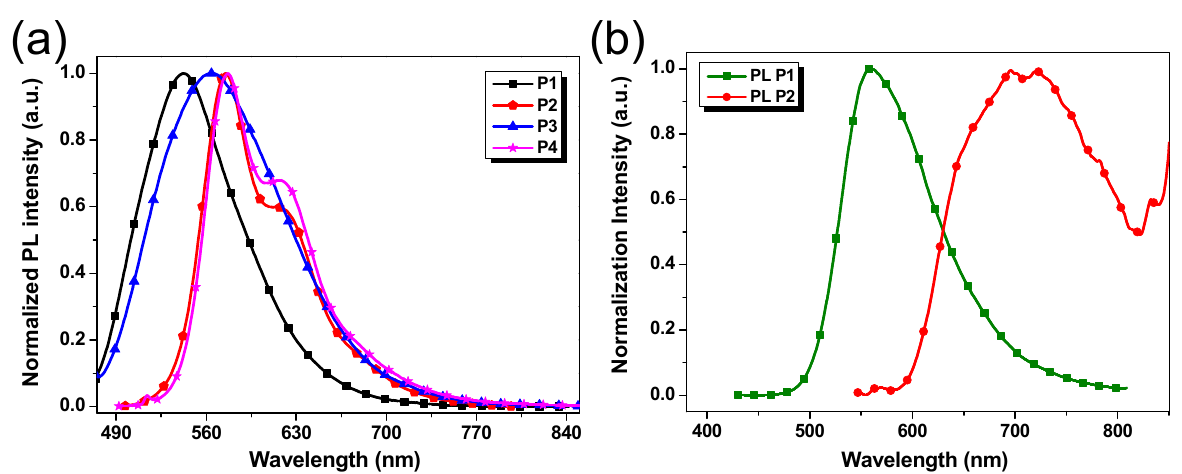
Figure 4. ( a ) Normalized PL spectra of P1 – P4 in dilute chloroform solutions (1 × 10 − 5 mol/L); ( b ) Normalized PL spectra in the thin film states of P1 and P2 .